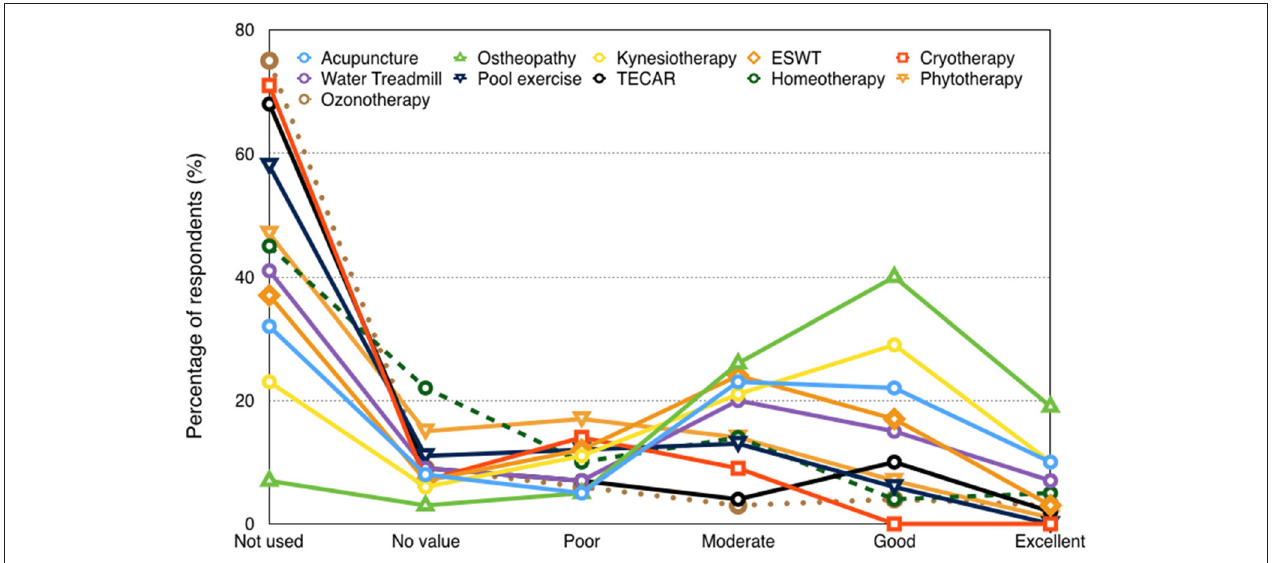
FIGURE 1 | Efficacy of the complementary therapies in treating horse’s back